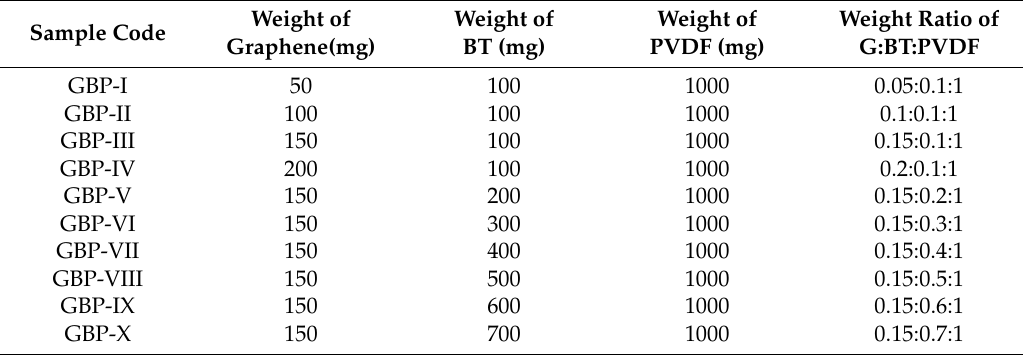
Figure 1. Schematic illustration of the synthesis of graphene/barium titanate/polyvinylidene fluoride (G/BT/PVDF) nanocomposite films. Table 1. Sample Codes and composition of prepared graphene/barium titanate/polyvinylidene fluoride (G/BT/PVDF) nanocomposite films.